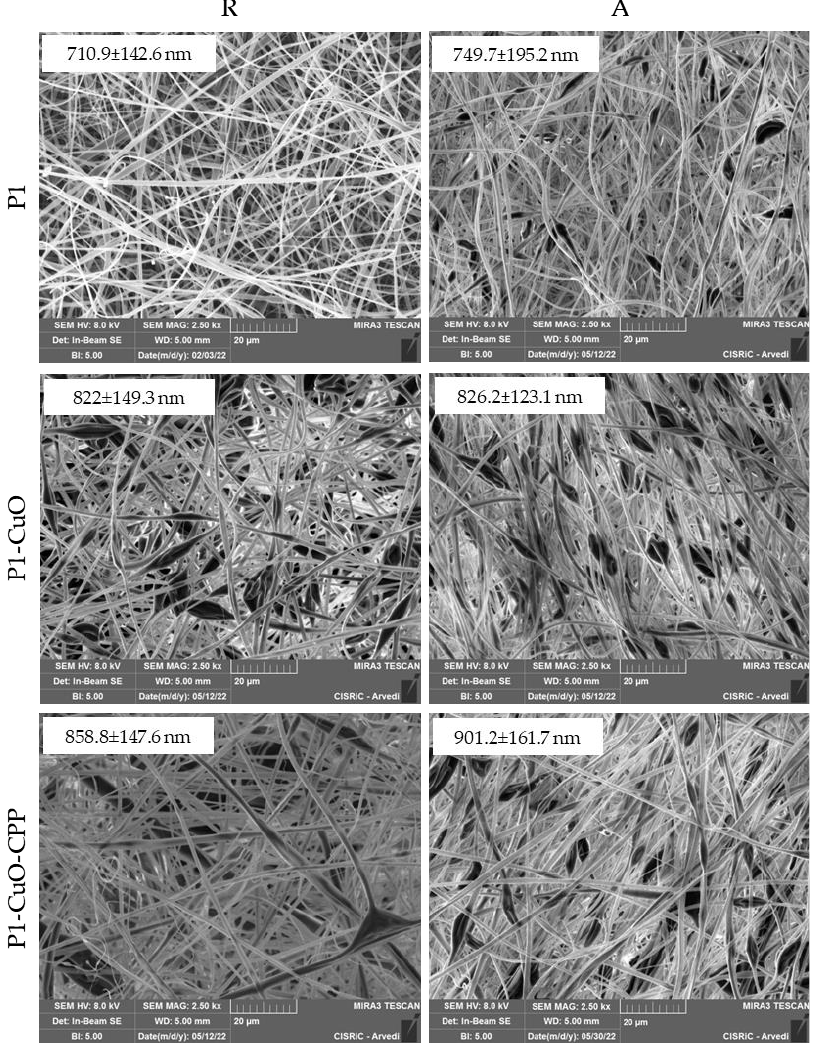
Figure 2. SEM micrographs of P1, P1-CuO, and P1-CuO-CPP scaffolds randomly collected (R) and aligned (A) at 2.5 kx magnification. In the insets, the corresponding dimensional analysis is shown (mean values ± SD, n = 30).